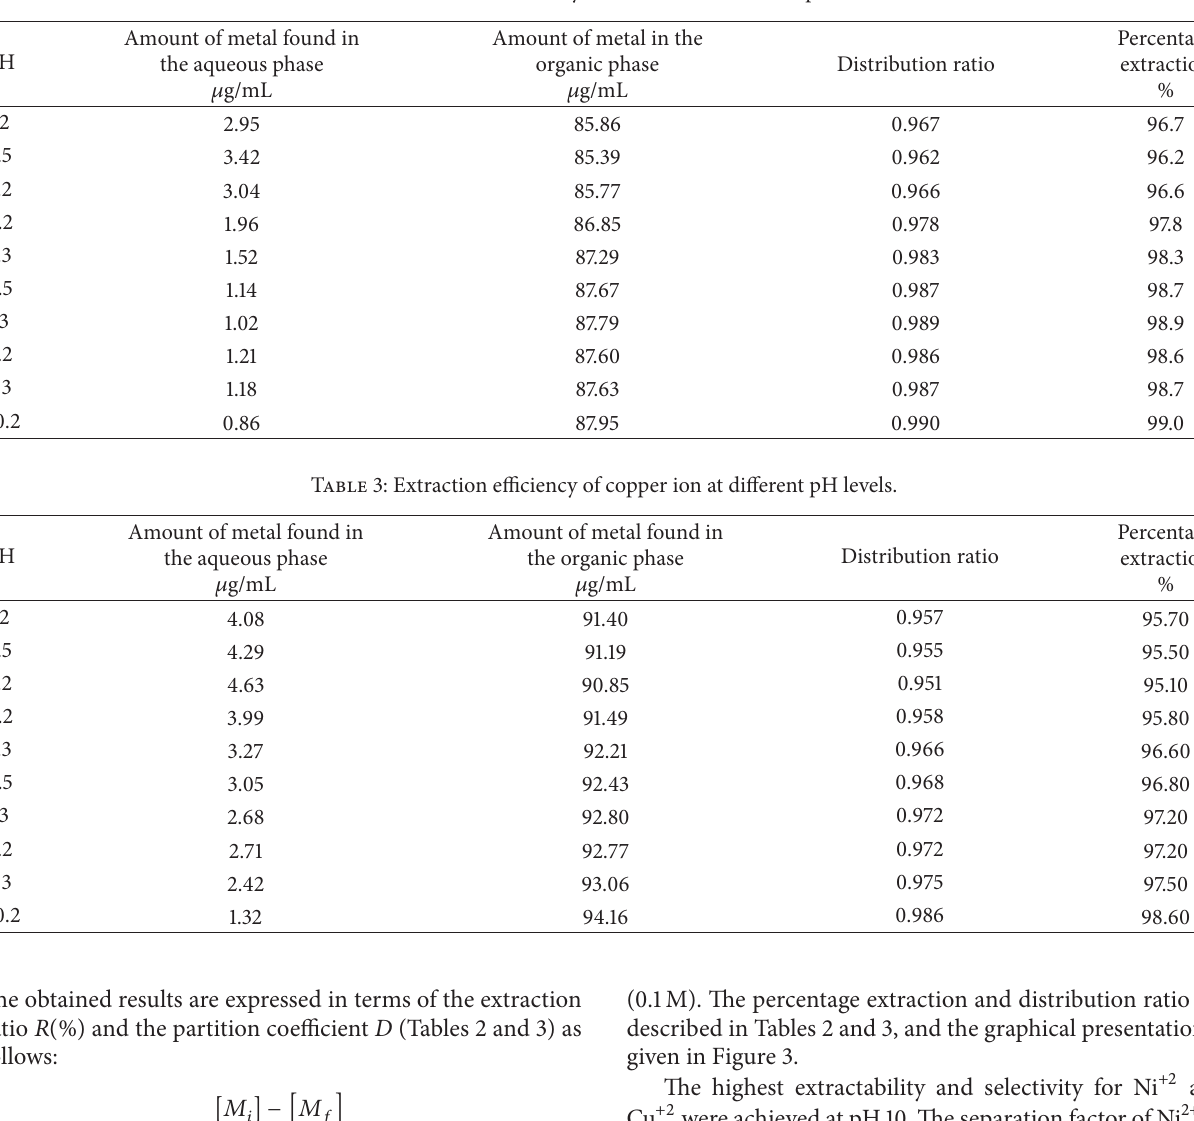
Table 2: Extraction efficiency of nickel ion at different pH levels.